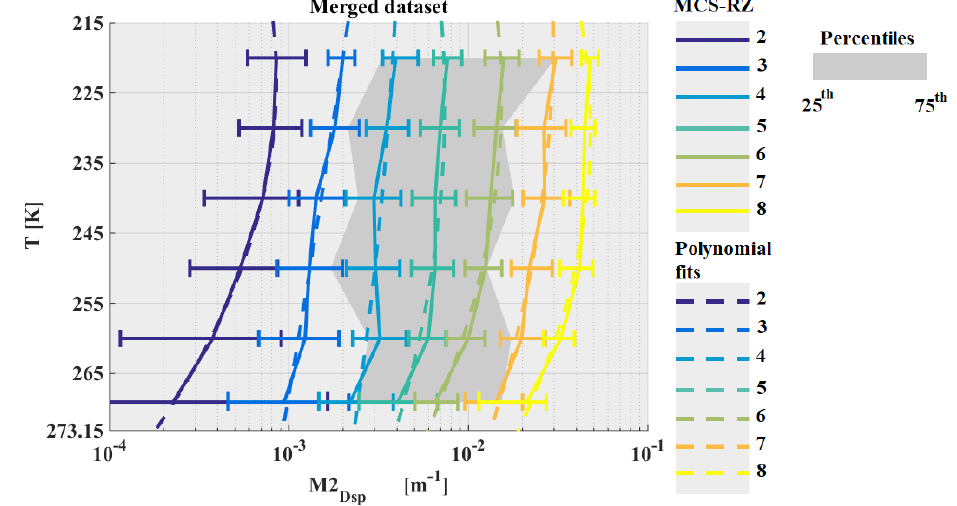
Figure E4. The same as Fig. 6 but for MRD- M 3 , Dsp , where PSD is used as a function of equivalent spherical